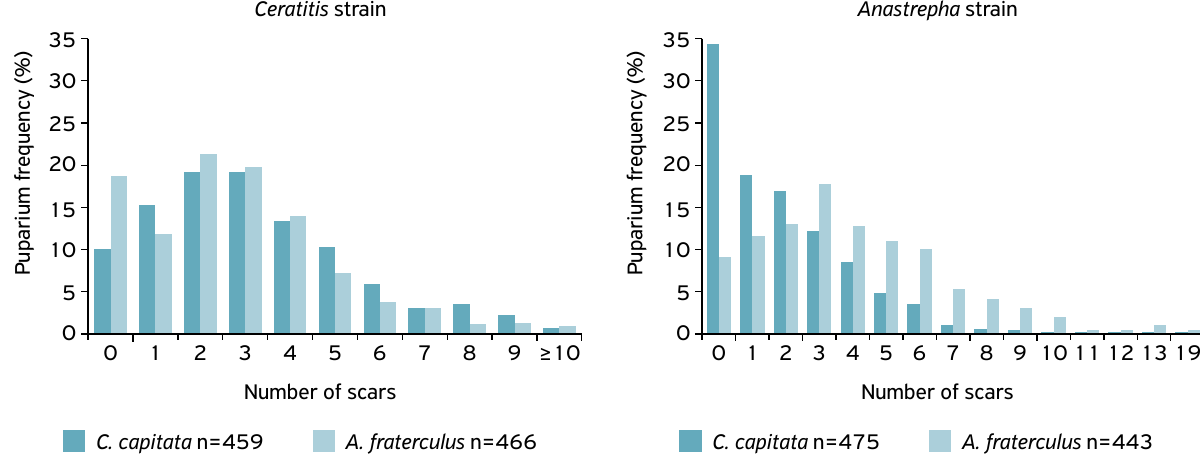
Figure 1. Distribution of parasitism intensity among the pupae of Anastrepha fraterculus and Ceratitis capitata parasitized by Diachasmimorpha longicaudata in no‑choice assays. CS: Ceratitis strain; AS: Anastrepha strain.